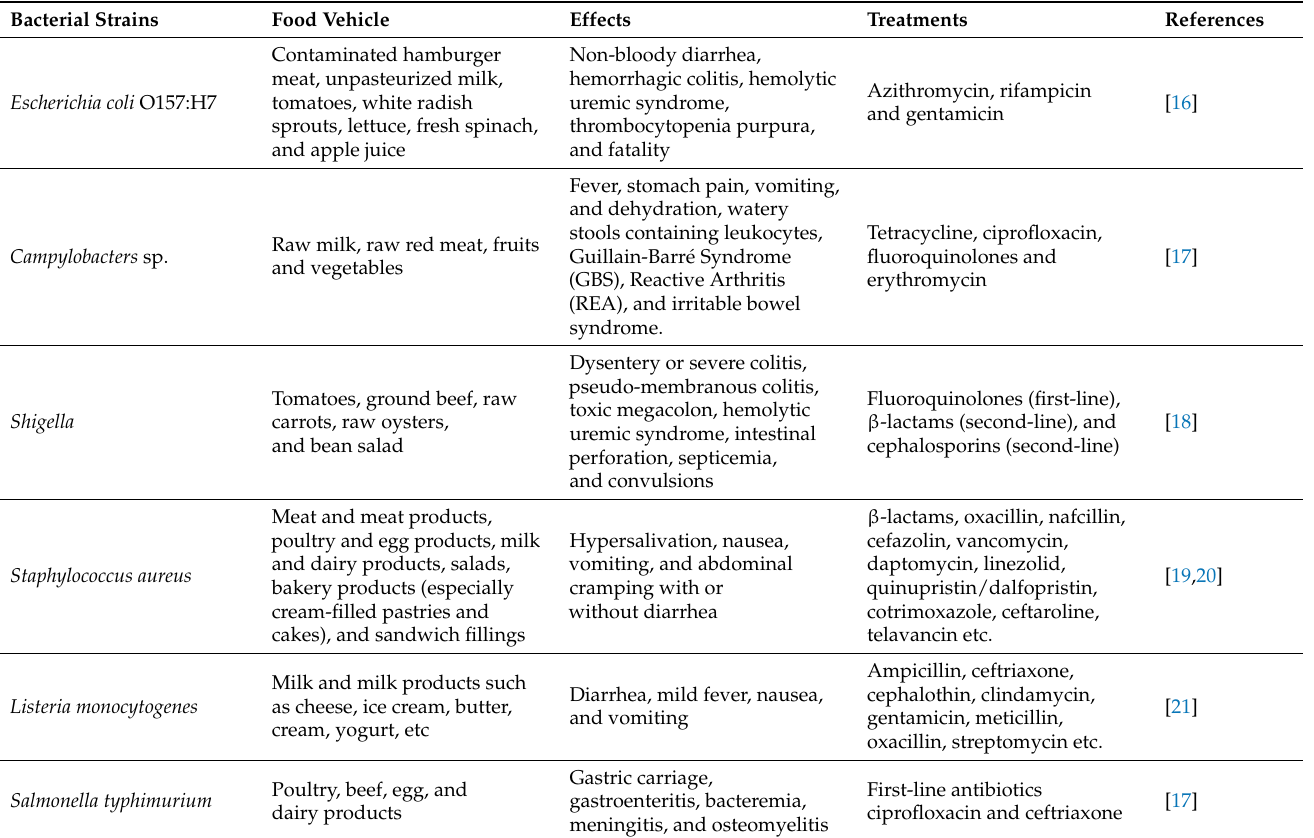
Table 1. Foodborne pathogens, their effect on humans, and available